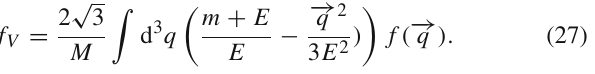
(cid:17) ee ( nS ) (cid:17) ee ( 1 S ) for